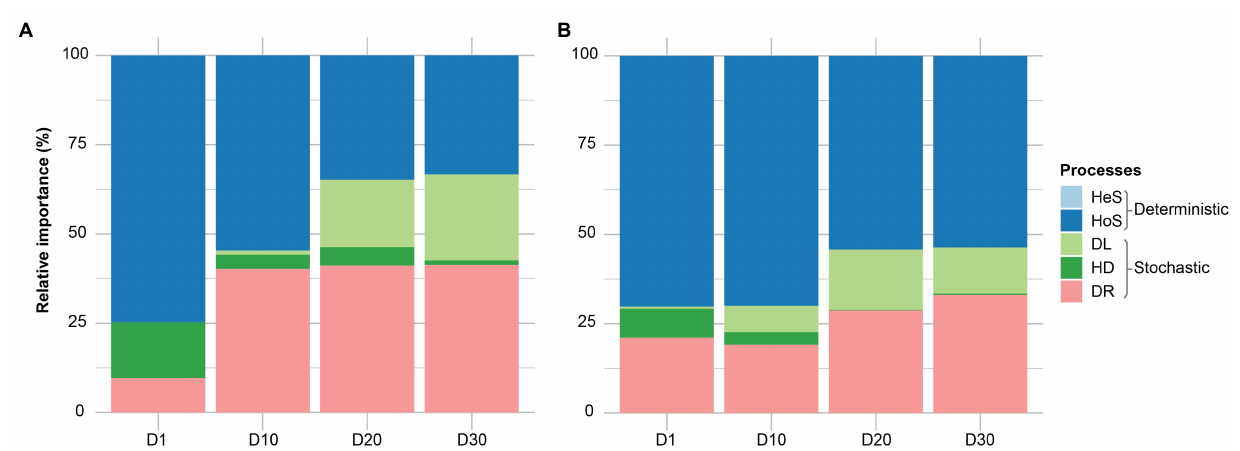
FIGURE 4 | The relative importance of different ecological processes involved in community assembly of membrane biofilms. Panels (A) and (B) represent the 16S rRNA amplicon sequencing dataset from DNA and cDNA, respectively. Here, “processes” particularly means community assembly processes, including heterogeneous selection (HeS), homogeneous selection (HoS), homogenizing dispersal (HD), dispersal limitation (DL), and ‘drift’ (DR). The definitions of these ecological processes related to community assembly are adopted from (Zhou and Ning, 2017). HeS refers to the selection process under homogeneous abiotic and biotic environmental conditions leading to more similar structures among communities. HoS refers to the selection process under heterogeneous abiotic and biotic environmental conditions leading to more dissimilar structures among communities. HD represents a very high rate of dispersal among communities, which homogenizes the communities such that their structures are very similar. DL is caused by the restriction in movement of individuals to and/or establishment of individuals (colonization) in a new location, leading to more dissimilar structures among communities. DR represents random changes, with respect to species identity, in the relative abundances of different species within a community over time due to the inherent stochastic processes of birth, death, and reproduction. D1, D10, D20, and D30 refer to sampling days 1, 10, 20, and 30, respectively. The dataset used in this analysis includes both flux and no flux